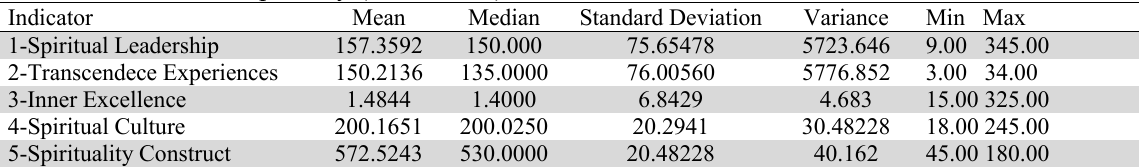
Fig. 1. The components of spirituality, ethics and higher education quality improvement Mean, Median, Standard Deviation of Minimum and Maximum of Spirituality and Ethics Construct